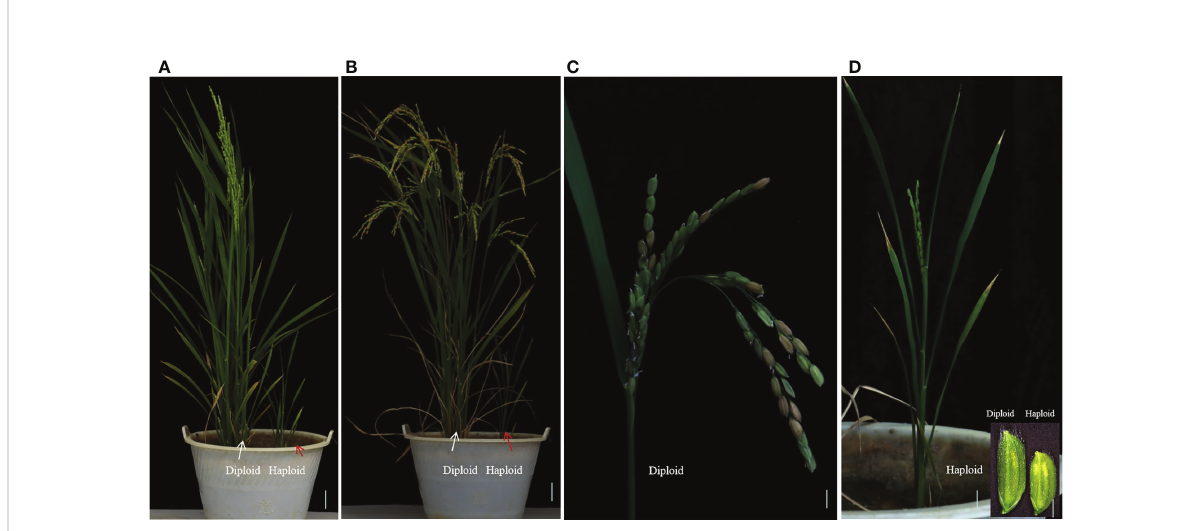
FIGURE 3 Characterization of double-seedlings in transgenic hybrid rice. (A, B) Two plants from double-seedlings are cultivated separately, Morphologies of the diploid (left; white arrow) and haploid (right; red arrow) is different at the heading stage (A) and at maturity. (B) Scale bars, 5 cm. (C) Panicle of the diploid in B is fertile. Scale bar, 2 cm. (D) panicle of haploid in B is sterile, and fl oret sizes of the diploid is larger than that of haploid plants. Scale bar, 2 cm. Inset scale bars, 2